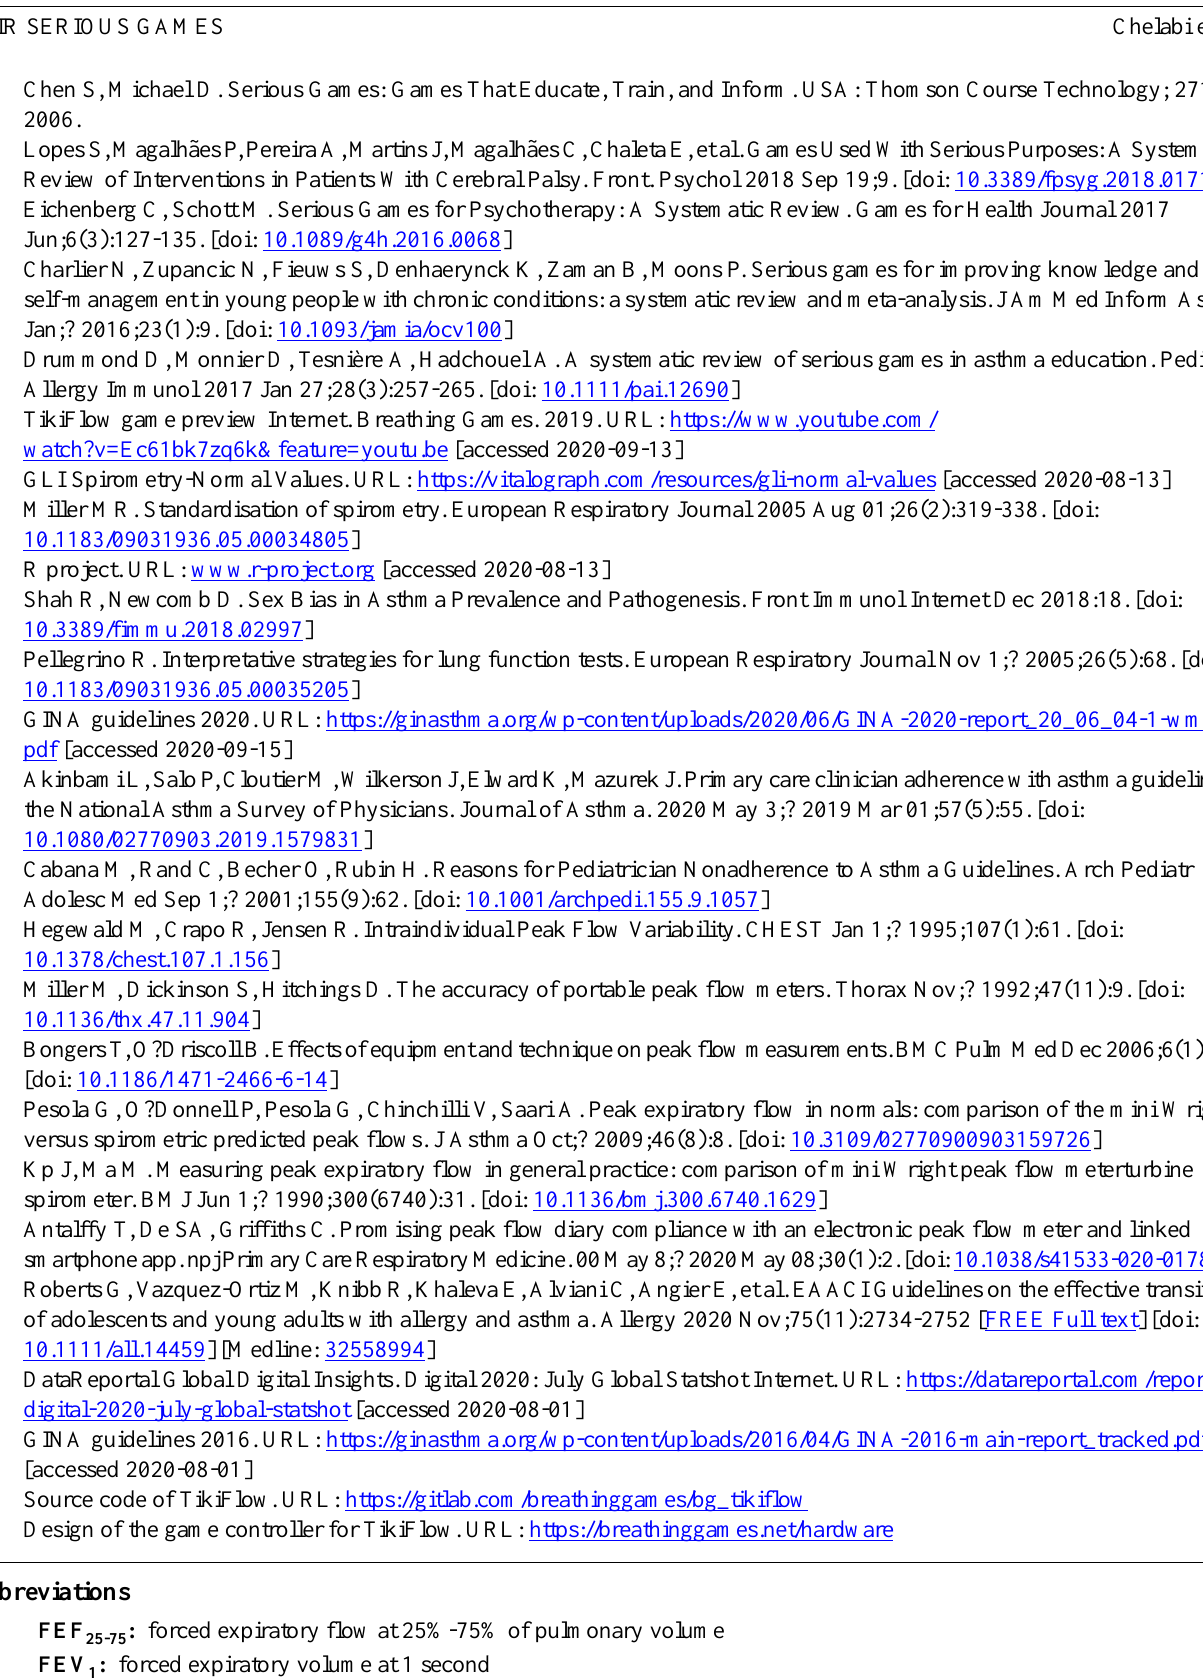
FEF : forced expiratory flow at 25%-75% of pulmonary volume 25-75 FEV : forced expiratory volume at 1 second 1 FVC: forced vital